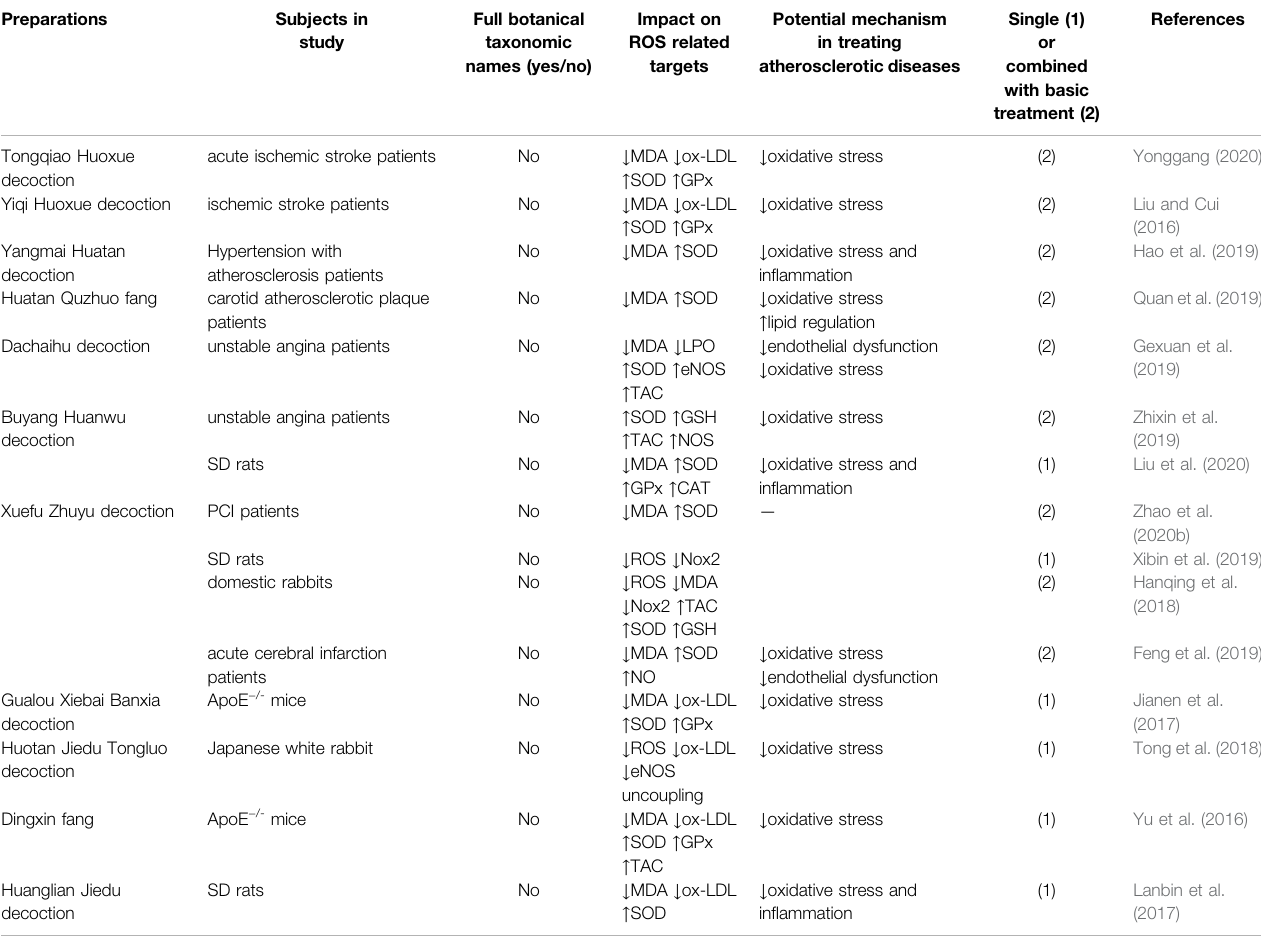
TABLE 8 | TCM preparations that treat atherosclerosis by regulating oxidative stress.